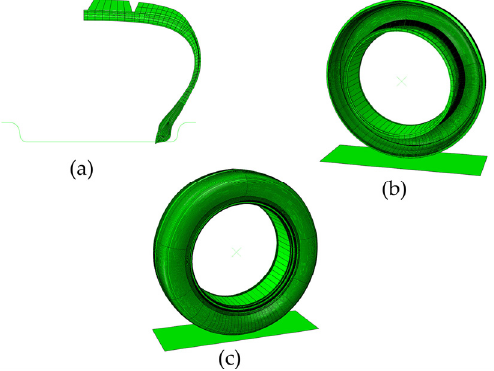
Figure 2. 205/55/R16 finite element model: ( a ) semi-2D tire section finite element model; ( b ) semi-3D tire finite element model; ( c ) full 3D tire finite element model.